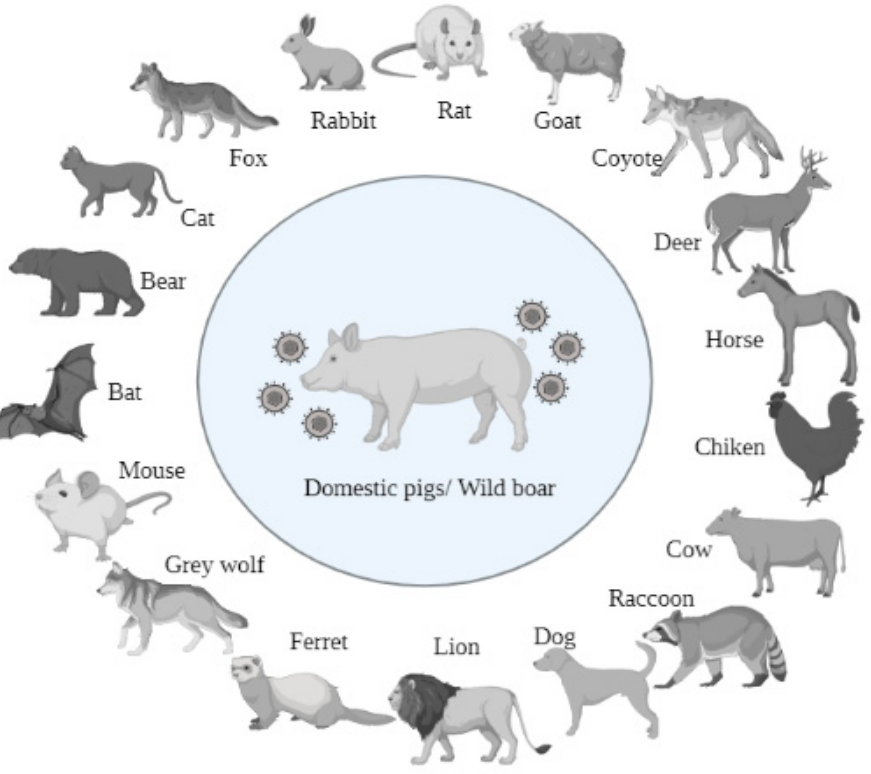
Figure 3. The reported animals that can be infected by PRV.